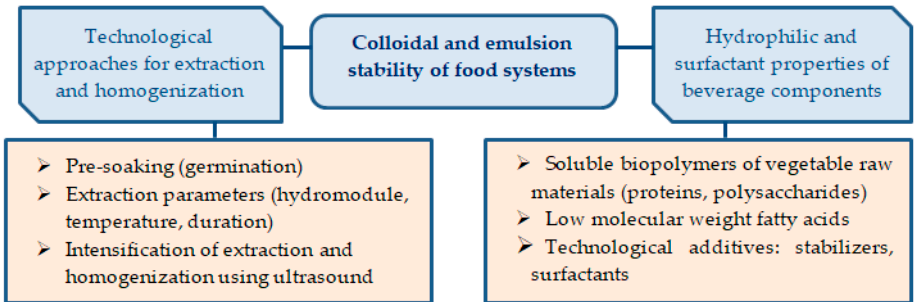
Figure 1. Factors providing colloidal and emulsion stability in plant beverages.